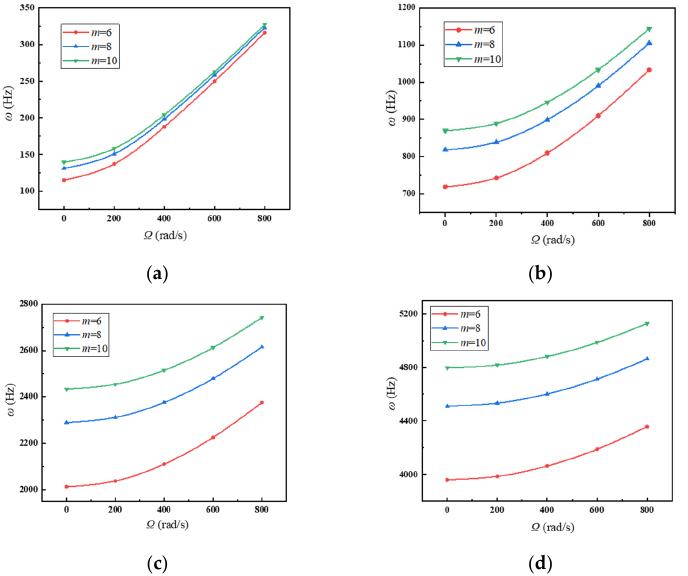
Figure 8. Variations of frequencies with rotating speed under different ratios of core layer thickness and surface layer thickness. ( a ) First frequency; ( b ) second frequency; ( c ) third frequency; ( d ) fourth frequency.